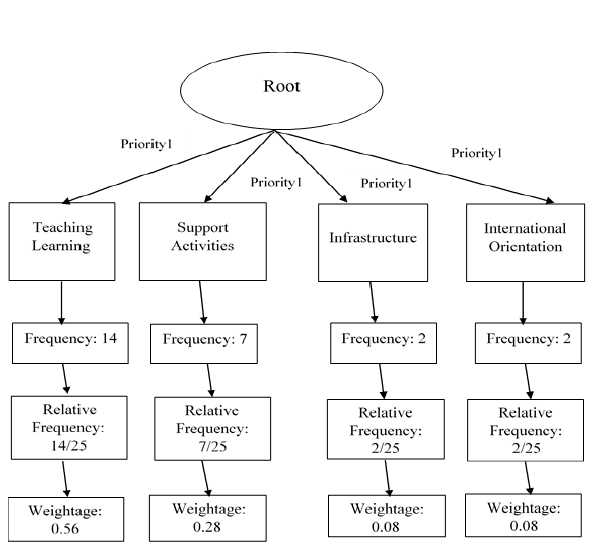
Figure 7. Weightage calculation of main parameters .